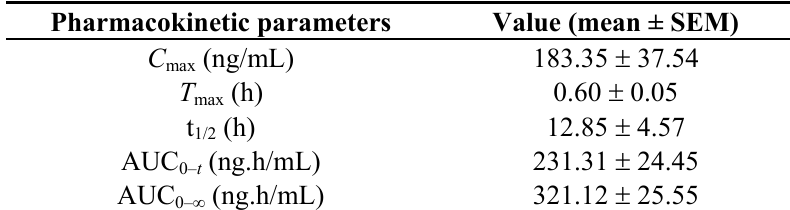
Table 1. Pharmacokinetic parameters of CRM after the administration of CRM-LF to human volunteers at a dose of 750